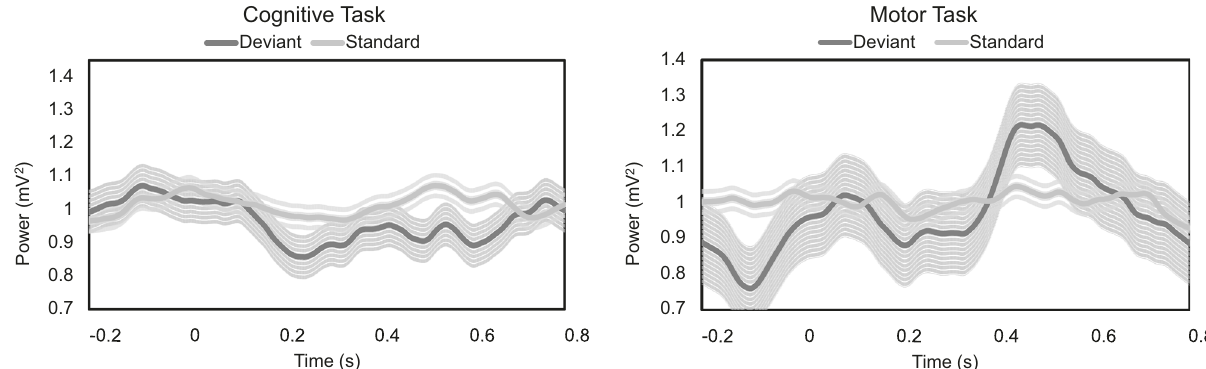
Fig. 7 Averages of beta LFPs for the motor and cognitive tasks. Averages of LFPs in the beta band frequency for the cognitive ( left ) and wrist fl icks task ( right ) ( n = 5 sequence of trials). Cognitive task reveals a beta desynchronization after the tone around 0.2 s and the rebounds around 0.8 s. On the same neurons, wrist fl icks are showing a similar pattern of beta desynch but with beta burst around 0.6 s. Results are mean ±